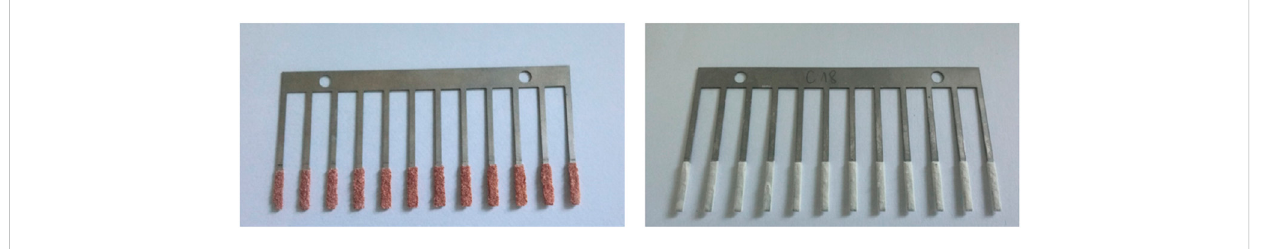
FIGURE 1 Two types of extraction solid phases used in the study. A-polystyrene divinylbenzene (PS-DVB) and B-polyacrylonitrile C18 (PAN-C18)